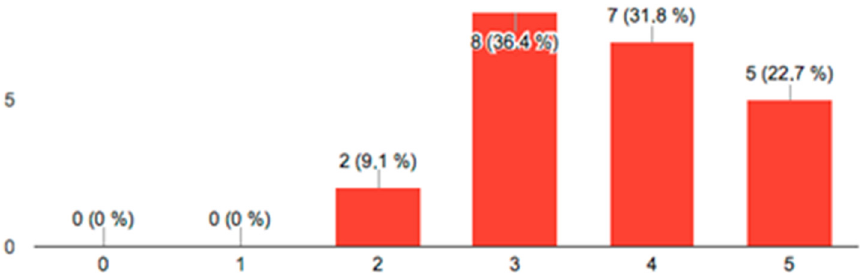
Figure 8. Ratings from 0 to 5 on the comfort of the scanning technique .